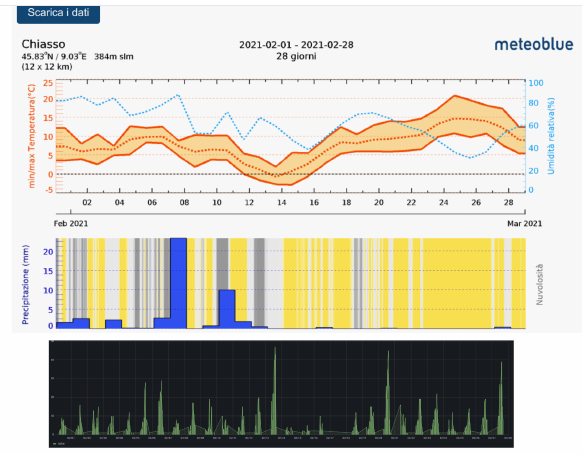
Figure 7. Temporal comparison of weather data and visitors passages at the Parco del Penz . Weather data published by www.meteoblue.com